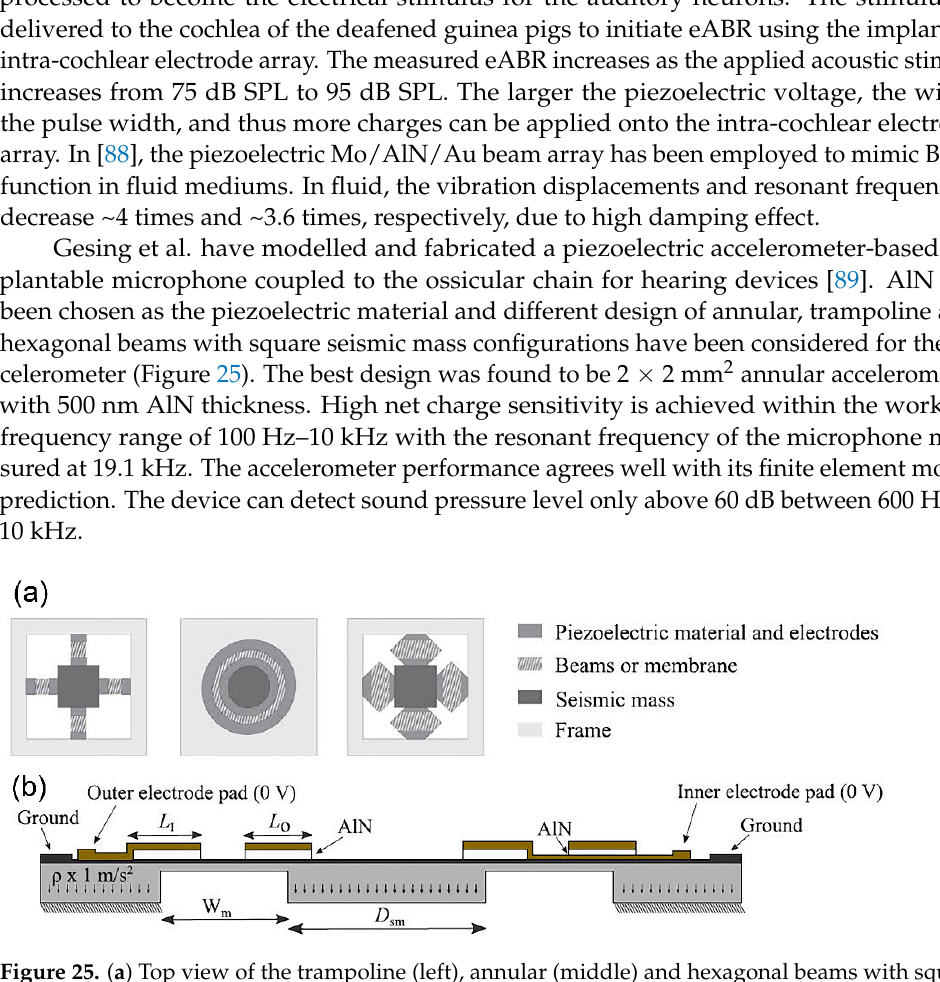
Figure 26. ( a ) The proposed piezoelectric cantilevers placement on the tympanic membrane ( b ) the bulk piezoelectric cantilever on the eardrum membrane model. © 2013 IEEE. Reprinted, with per- mission, from [90]. Žák et al. proposed an array of 24 isolated membranes with different dimensions to detect and filter acoustic signals [43]. The freestanding membrane is made of Si x N y with